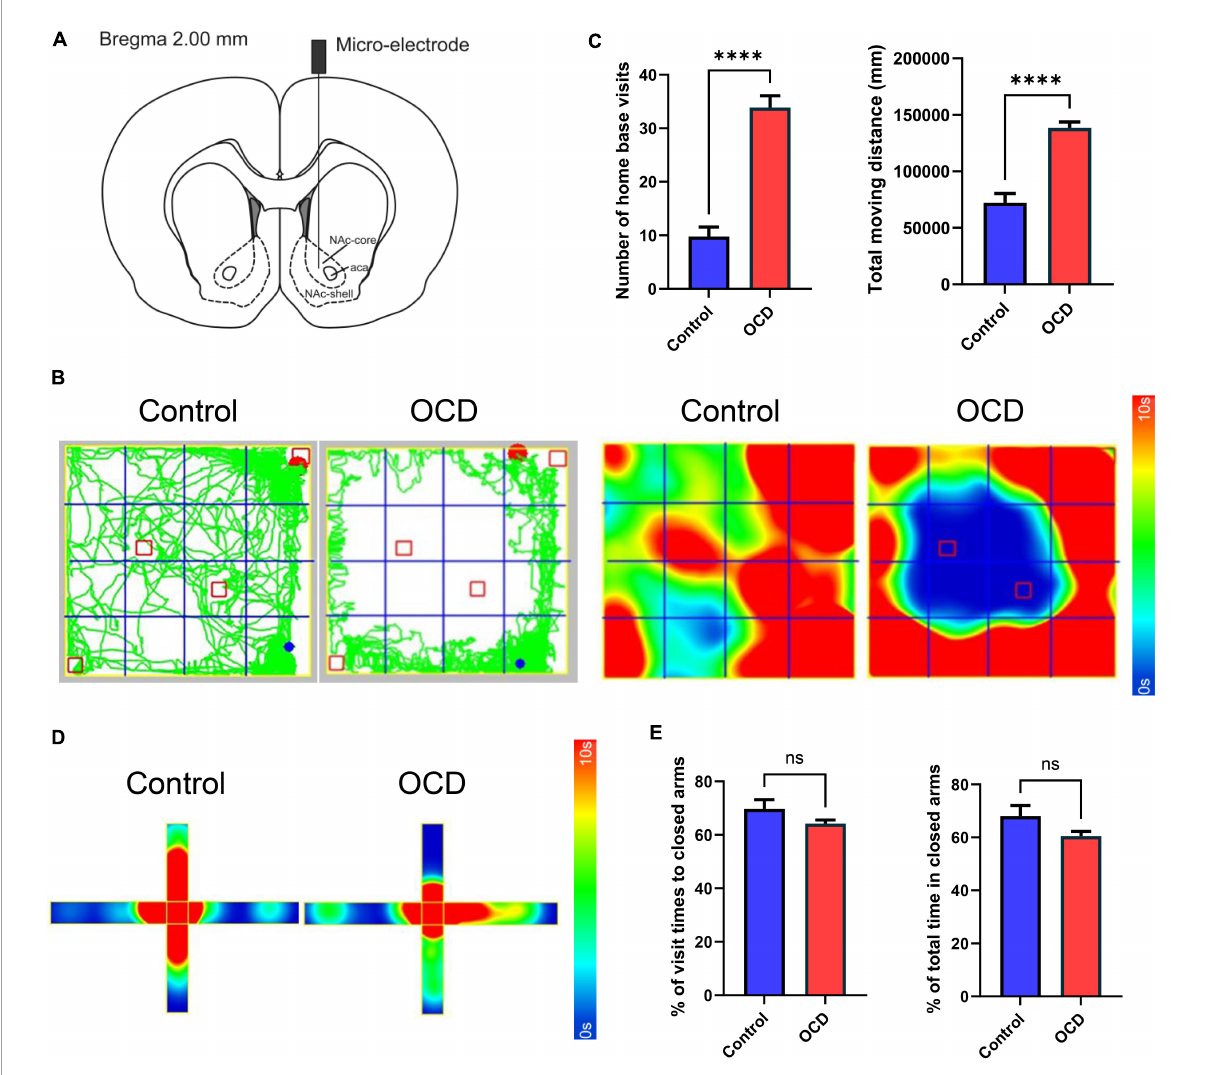
FIGURE3 Location instruction and behavioral assessments. (A) Schematic diagram indicating the location of the micro-electrode in the NAc, modified from the stereotaxic atlas of Paxinos and Watson (6th edition). (B) Traces and 2D heatmaps of rats injected with QNP (OCD) and saline (control) in the OFT. (C) The bar graphs represent the level of number of home base visits and total moving distance in the OFT, by the control and OCD groups. (D) 2D heatmaps of rats in the EPM. The horizontal direction represents the closed arms, and the vertical direction represents the open arms. (E) The bar graphs represent the level of percentage of visit times to closed arms and percentage of total spent time in closed arms. OCD, obsessive-compulsive disorder; QNP, quinpirole; OFT, open field test; EPM, elevated plus maze; DBS, deep brain stimulation;